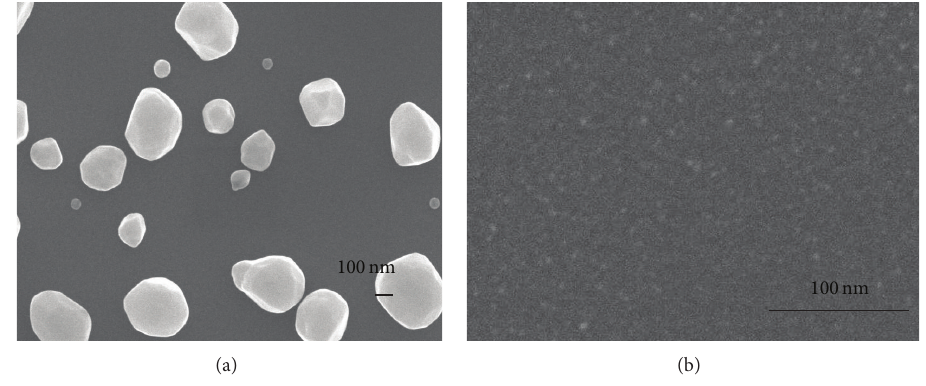
Figure 10: Galvanic displacement of GaAs with various metals, (a) Ag and (b)